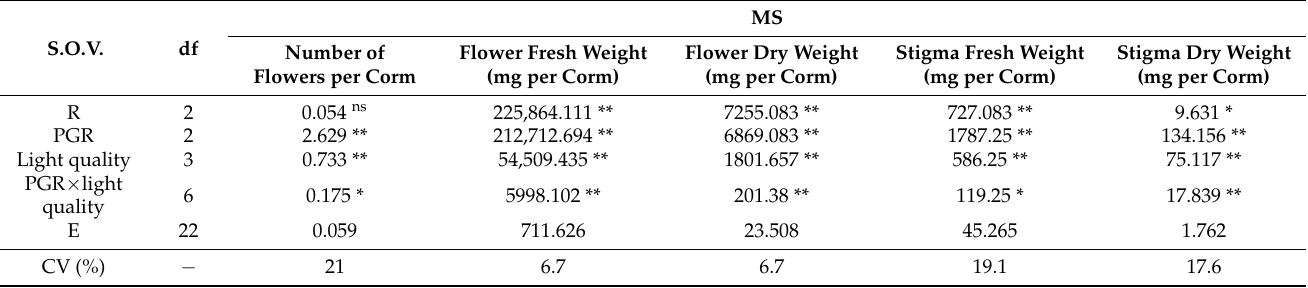
Table 1. Analysis of variance for the effect of treatments on flower characteristics of